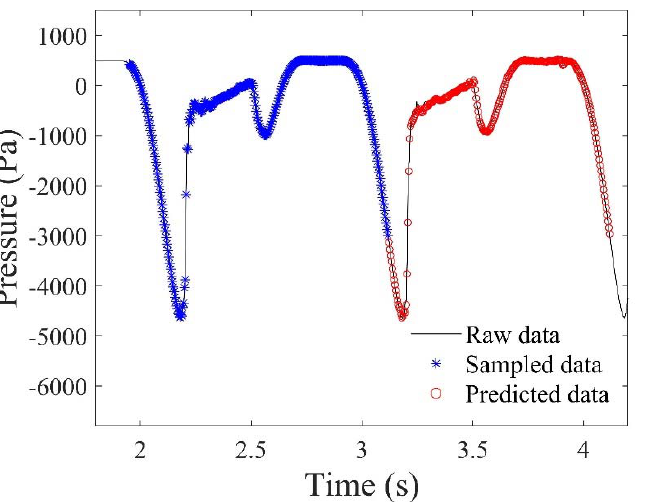
Figure 9. Prediction of future pressure data based on Koopman operator obtained by DMD with time-delay